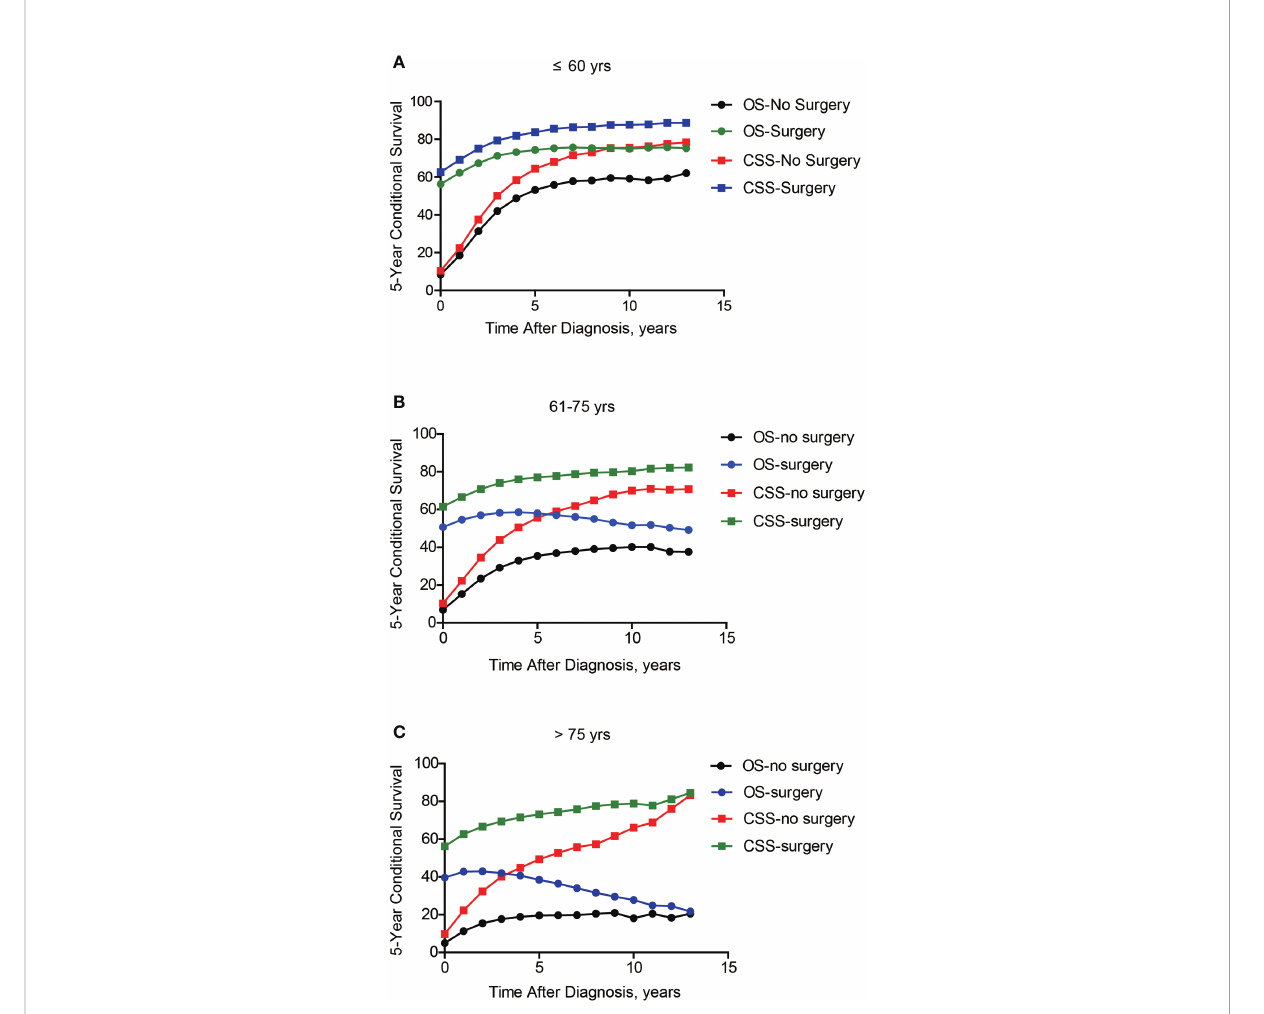
FIGURE 5 Subgroup analyses of 5-year conditional survival based on surgical treatment in lung cancer patients with different ages. Subgroup analyses of 5-year conditional survival rate based on surgical treatment or not of those aging ≤ 60 yrs (A) , 61-75 yrs (B) , or > 75 yrs (C)